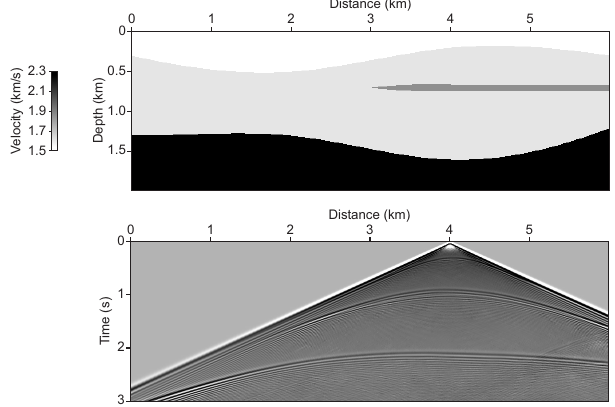
Figure 1. Velocity model used to calculate synthetic data (top) and a shotgather generated at x = 4 km (bottom).